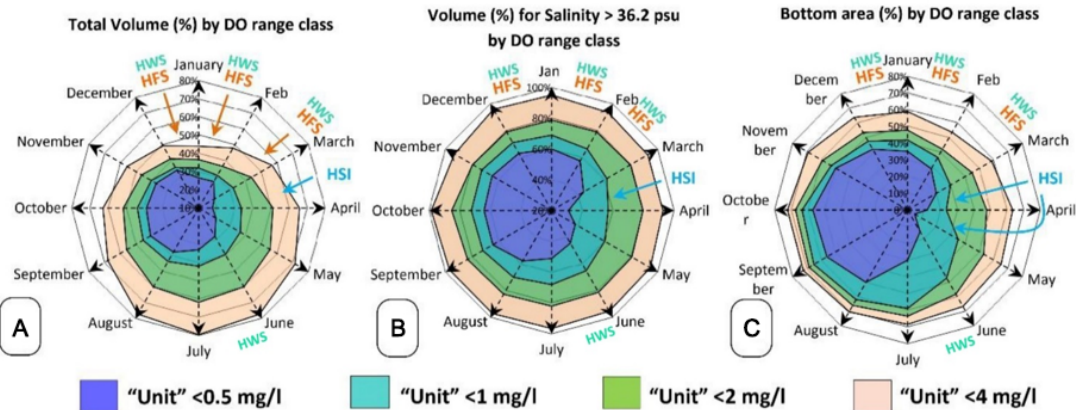
Figure 7. Radar plots showing ( A ) total water volume percentage based on different DO classes (DO < 4 mg/L, DO < 2 mg/L, DO < 1 mg/L, DO < 0.5 mg/L), (HFS: high freshwater supply), (HSI: high seawater intrusion), (HWS: high wind speed); ( B ) water volume percentage of CTD with salinity higher than 36.2 PSU based on different DO; and ( C ) seafloor area percentage that is covered by different DO range classes